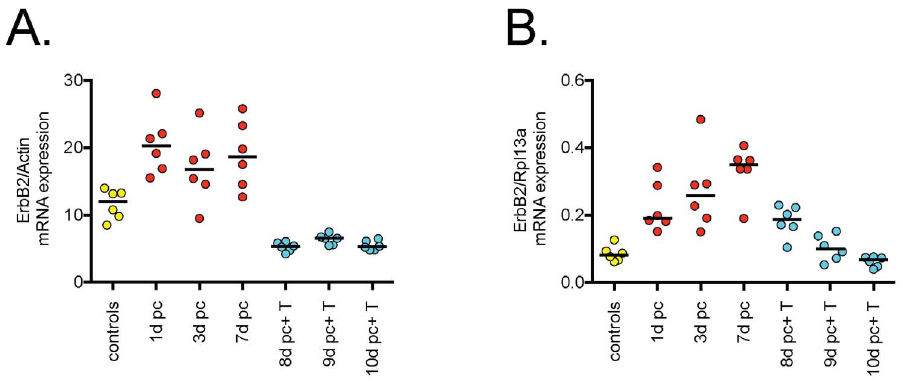
Figure 3. Relative expression of ErbB2 in the rat prostate following castration and androgen reinstatement. Data are normalized to A. ß-actin; B, Rpl13a. Abbreviations: d pc, number of days post-castration; T, testosterone. Shown are the individual values (n=6 per group); the solid bars indicate medians. In both cases, Kruskal-Wallis tests indicated a significant variation between the groups (P , 0.0001). doi:10.1371/journal.pone.0105063.g003 PLOS ONE |